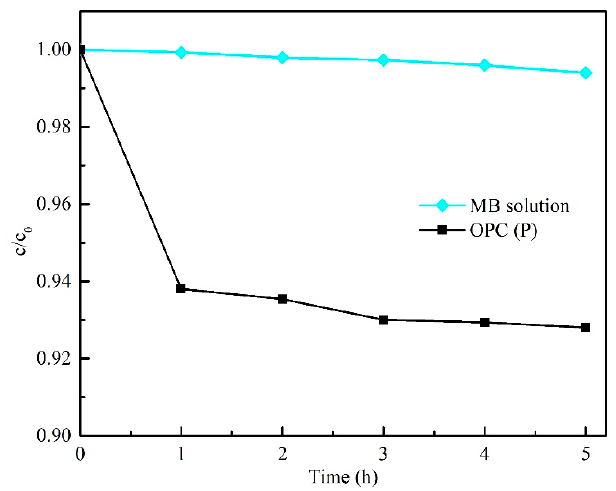
Figure 9. Concentration change of MB solution with and without OPC (P) under dark conditions.